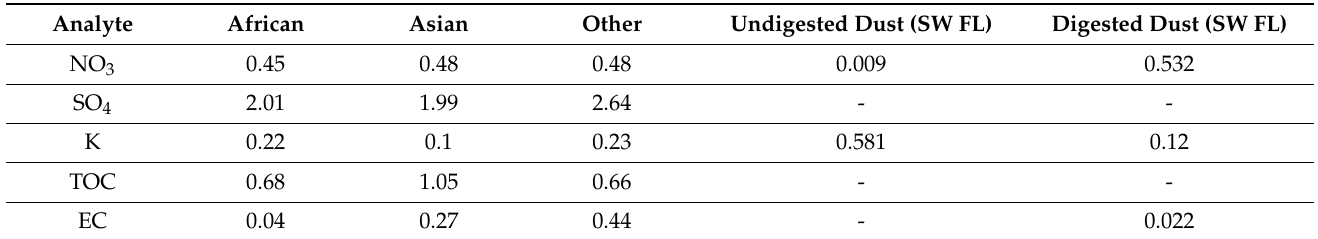
Table 5. The average concentration of nitrate, sulfate, potassium, organic carbon (OC), and elemental carbon (EC) pertaining to the three categories of fine dust sources (African, Asian, and “Other”) measured at the EVER1 station in South Florida [6] compared to the average concentrations found in this study. All concentrations are in mg/m 3